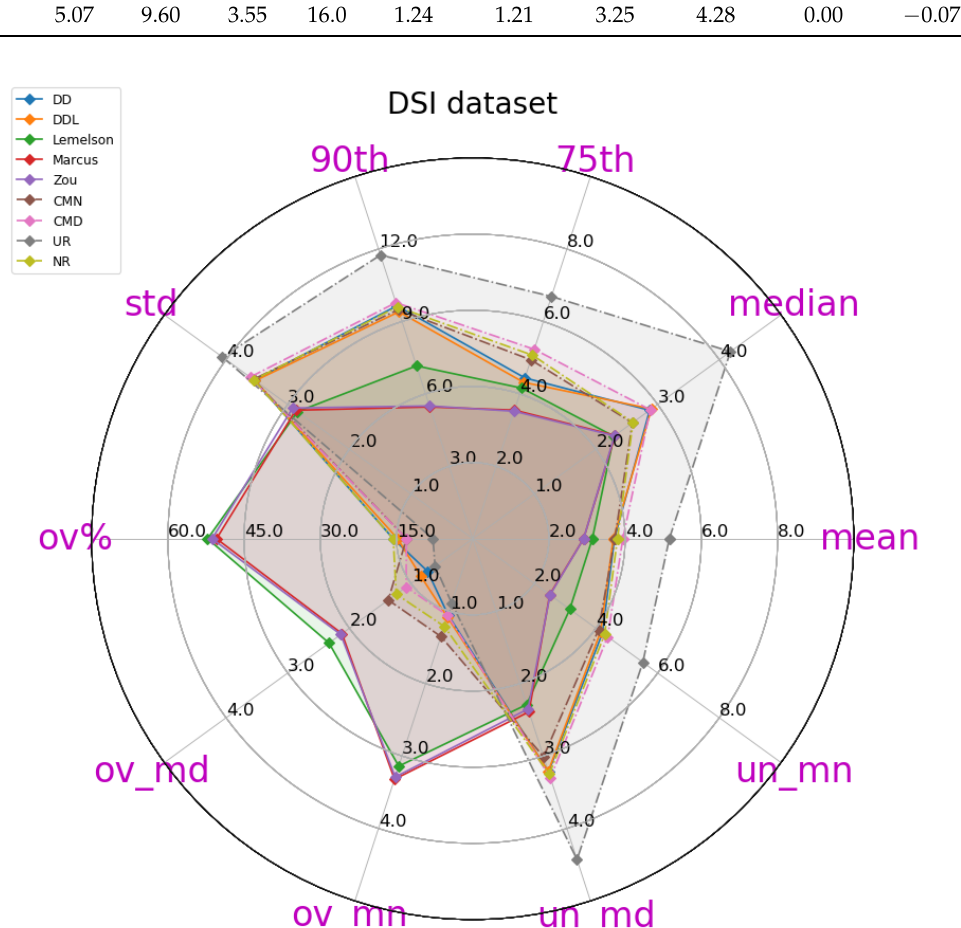
Figure 14. A radar plot of most of the relevant metrics for the DAE evaluation of various methods, on the validation set of the DSI dataset. Methods are depicted in continuous lines while baselines are in dashed lines. This plot depicts metrics and values of all methods, as reported in Table